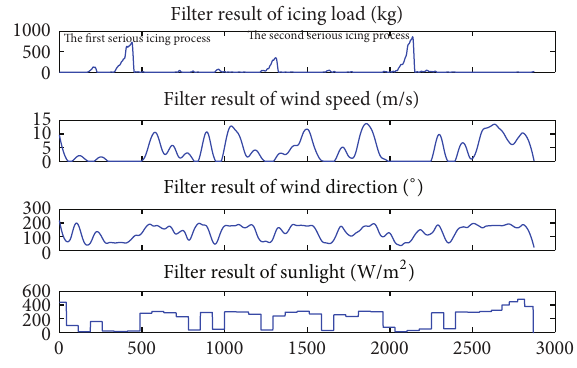
Figure 4: Filter results of 𝑞 𝑊 , 𝑊 𝑃 , 𝑊 𝐷 , and 𝑆 𝐿 .